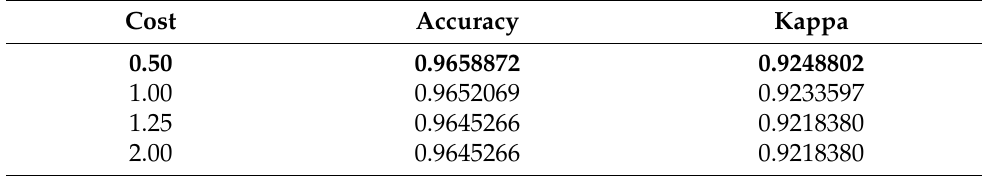
Table 4. Parameter Setting for SVM after applying PPFS-GAF for the Breast Cancer